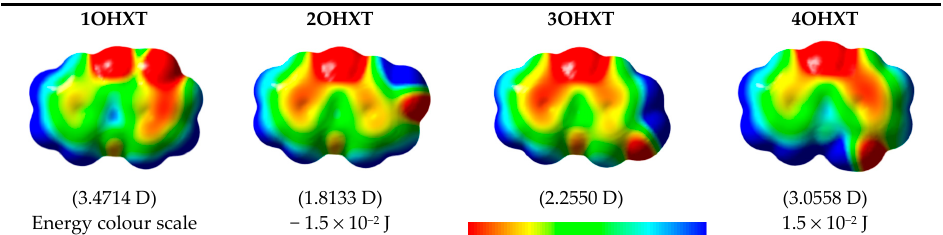
Figure 2. Electrostatic potential energy surfaces mapped onto an electron density isosurface (isovalue for spin density of 0.0004 e · a 0 − 3 ; where a 0 is the Bohr radius and corresponds to 5.2917721067 × 10 − 11 m [28] and e is the electron charge, 1.6021766208 × 10 − 19 C [28]), and dipole moment values for the global minimum conformer of each monohydroxyxanthone isomer.